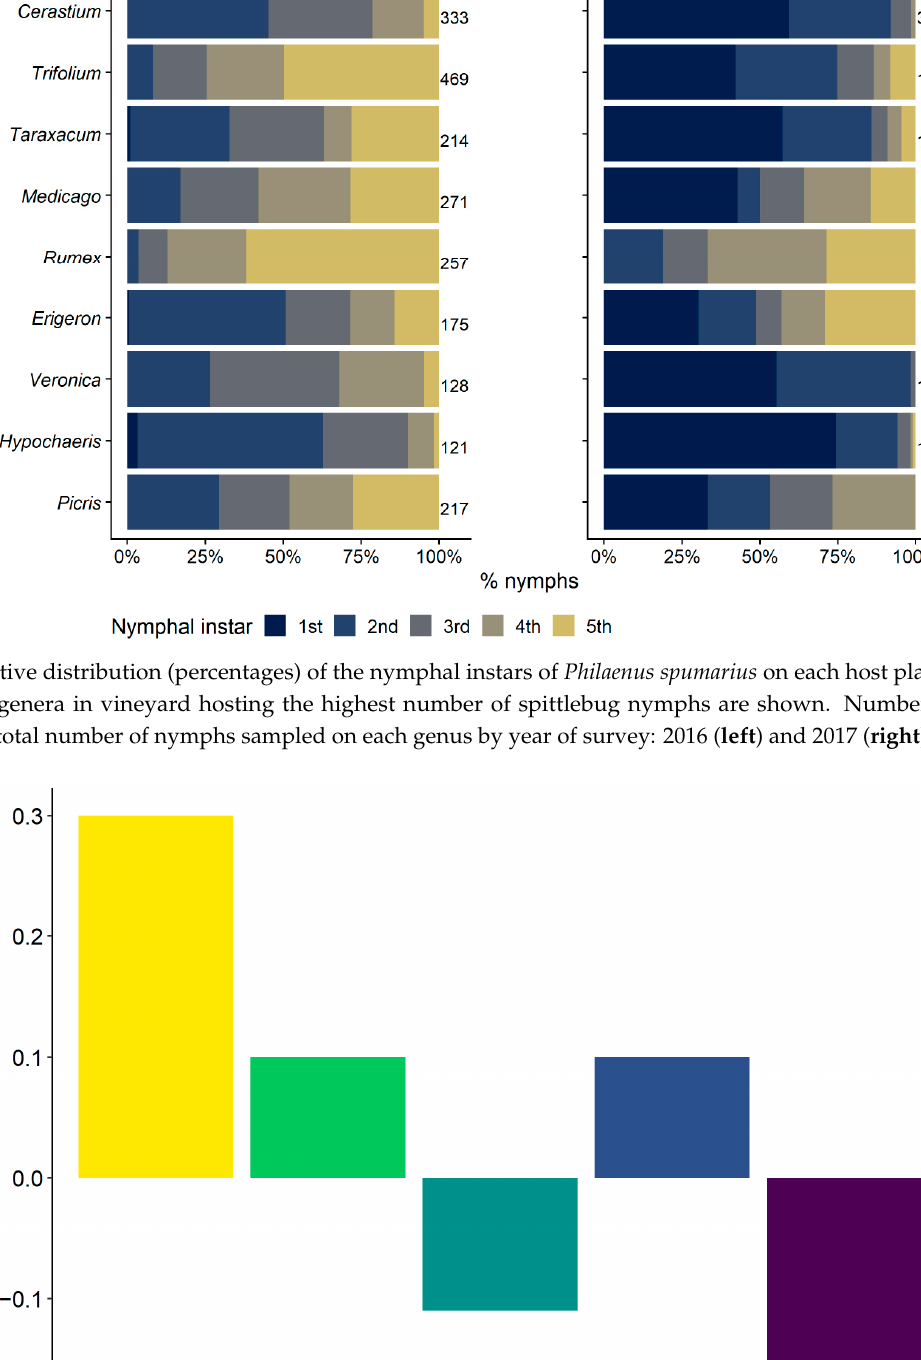
Figure 7. Kullback–Leibler (KLD) index estimating the level of attractiveness of the most common plant families in the 2016–17 survey for the nymphs of Philaenus spumarius .